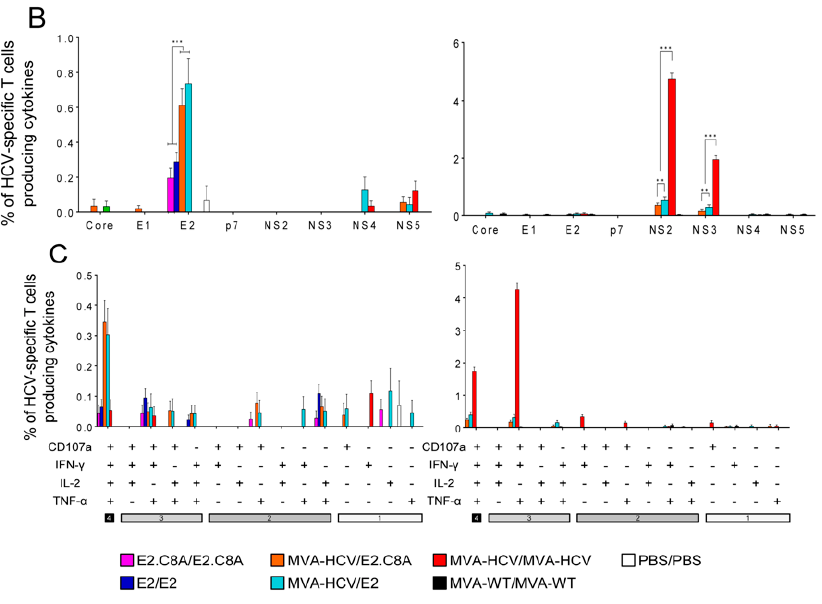
Figure 5. Memory CD4 + and CD8 + HCV-speci fi c T cell immune responses in immunized mice. p values indicate significant response differences between immunization groups (* p < 0.05; ** p < 0.005; *** p < 0.001). ( A ) Magnitude of the total HCV-speci fi c CD4 + and CD8 + T cell responses after stimulation of splenocytes with the different HCV peptide pools. The total value in each group represents the sum of the percentages of CD4 + and CD8 + T cells secreting CD107a and/or IFN- γ and/or IL-2 and/or TNF- α against HCV antigens. Dashed line separates groups stimulated only with E2 peptide pools (left) from groups stimulated against all HCV antigens (right). ( B ) Breadth of the HCV-specific T cell response shown as the percentage of cells secreting CD107a and/or IFN- γ and/or IL-2 and/or TNF- α against each HCV peptide pool. ( C ) Polyfunctionality of the HCV-specific T cell response shown as the combined production of CD107a and/or IFN- γ and/or IL-2 and/or TNF- α against all HCV peptide pools. Figure 6. Memory phenotype of T cell immune responses in immunized mice. Phenotypic profiles of splenocytes from the memory phase ( n = 4 mice per group) were analyzed by Intracellular Cytokine Staining (ICS) assay. Graphs indicate the percentages of CD4 + (left) and CD8 + T (right) central memory (TCM; CD127 + CD62L + ), effector memory (TEM; CD127 + CD62L - ), and effector (TE; CD127 - CD62L - ) cells expressing CD107a and/or producing IFN- γ and/or TNF- α and/or IL-2 against all genotype 1a HCV peptide pools. p values indicate significant response differences between immunization groups (*** p < 0.001).